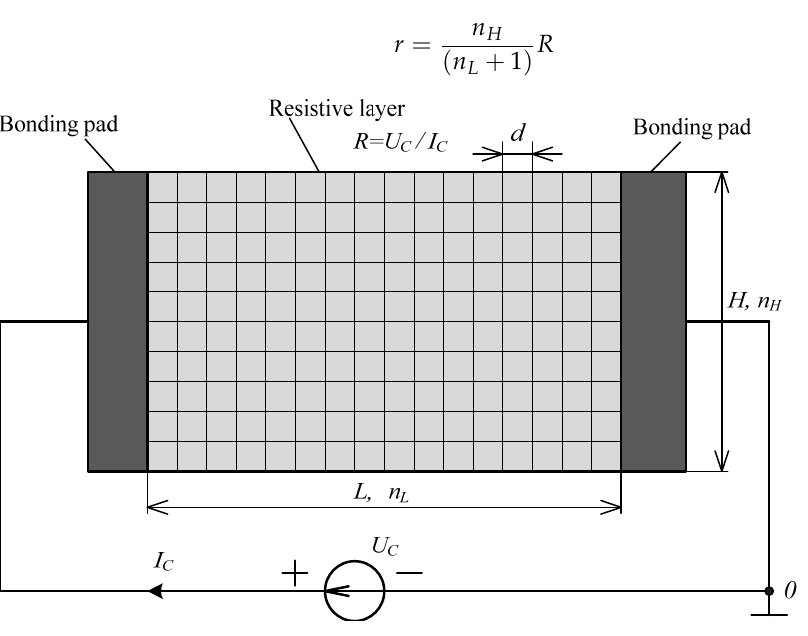
Figure 1. Resistor element model with discrete node mesh.